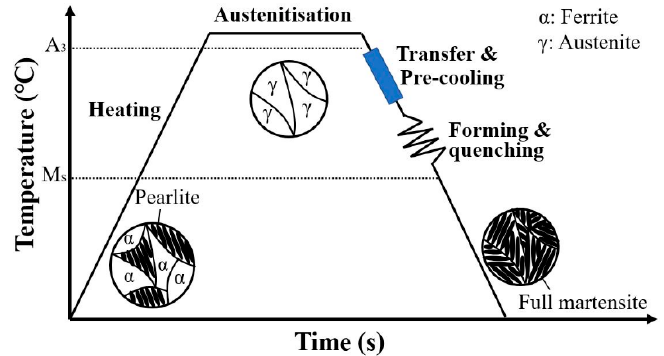
Figure 6. Schematic illustration of hot stamping process for Mn-B steel with lower forming temperature, showing microstructural evolution at each stage.